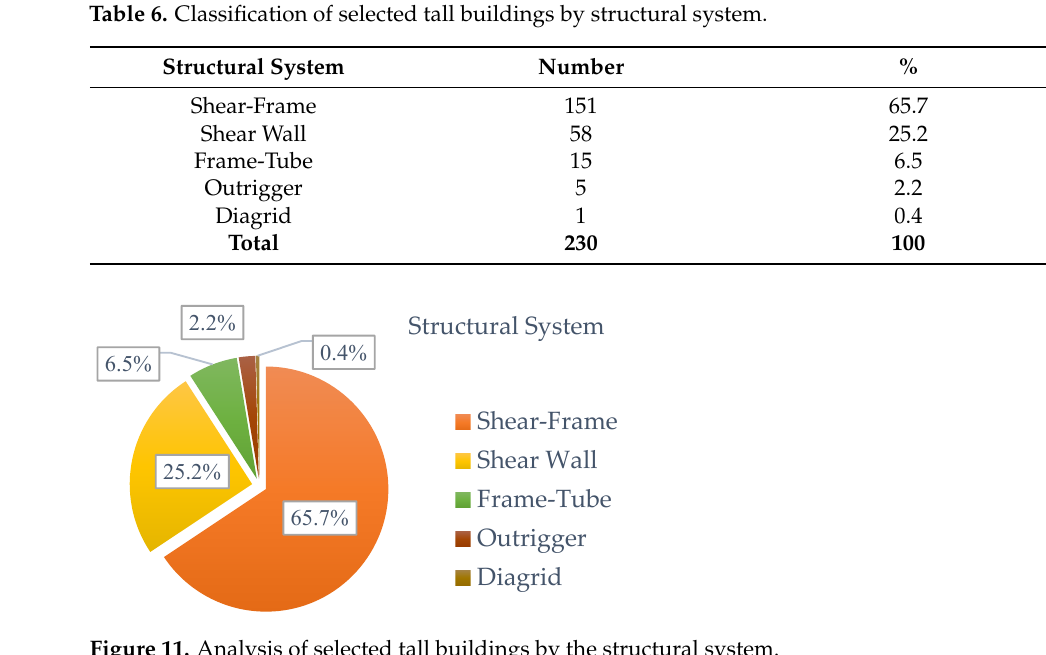
Figure 11. Analysis of selected tall buildings by the structural system.